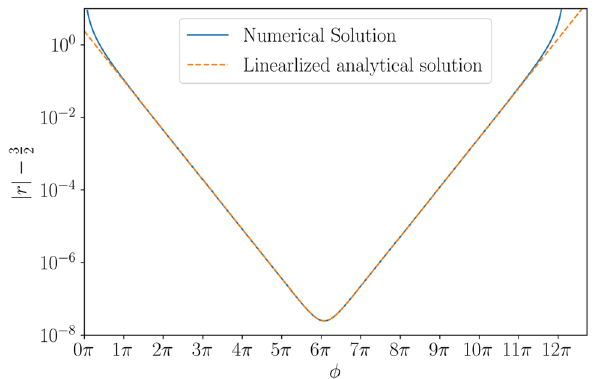
15 10 ) and the last photon orbit as a function − = 16 1 , the linearised 10 1 . For u u eq and δ 1 − − ≈ ≈ ≈ −